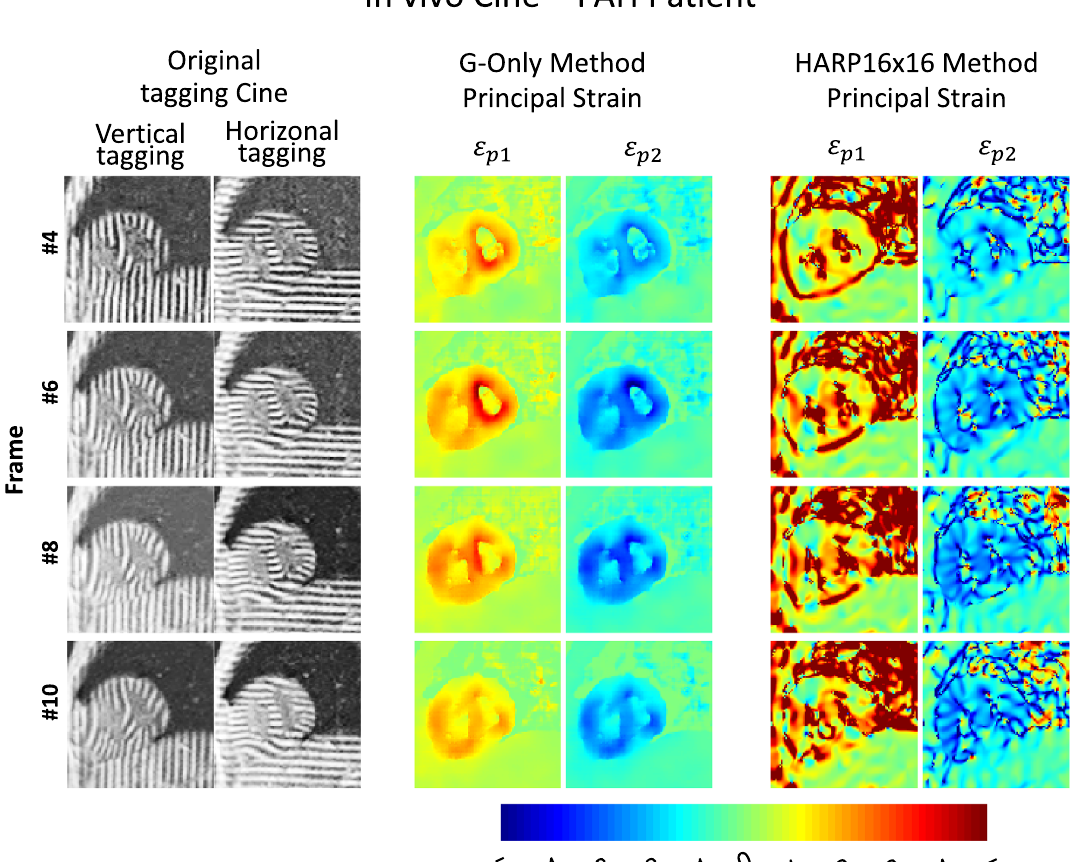
Figure 6. In-vivo cine demonstration of the strain maps generated by G-Only versus HARP in a PAH patient. Throughout the cardiac cycle, and compared to HARP, the G-Only GAN network produced the principal strain maps at the original image native resolution with crisp anatomical boundary details and without artifacts. An additional movie file shows this in more detail [see Additional file